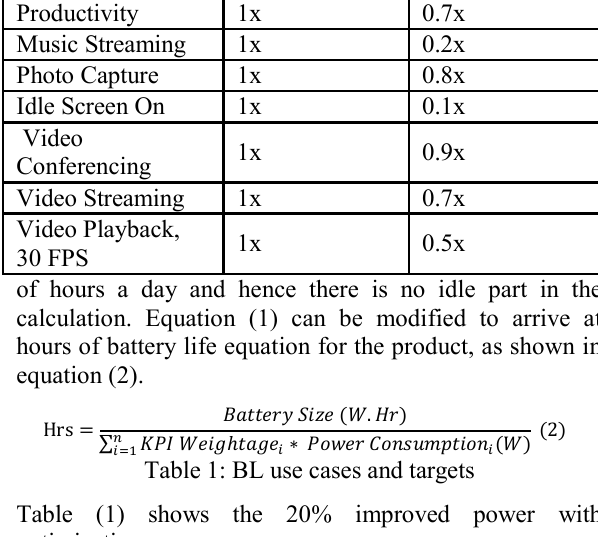
(2) Table 1: BL use cases and